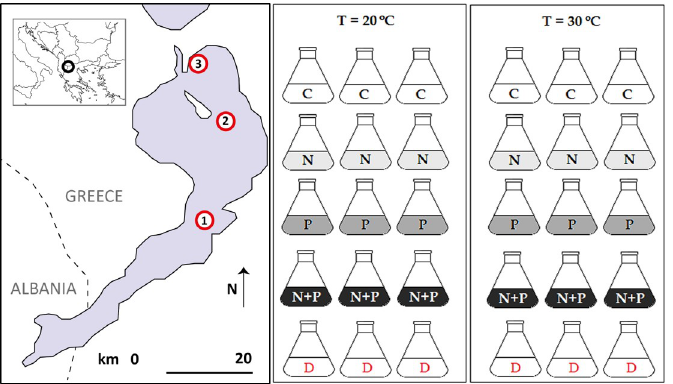
Fig 1. Experimental set-up. (A) Locations of water sampling sites at Lake Lesser Prespa in 2015 (site 1, 2, 3). (B) the set-up of the algal bioassay per sampling site; per site 30 flasks were incubated at two different temperatures (20 and 30˚C) and received five different nutrient treatments—no nutrient addition/control (C), nitrogen addition (+N), phosphorus addition (+P), addition of both nitrogen and phosphorus (+N+P) and addition of pelican droppings (D), all in